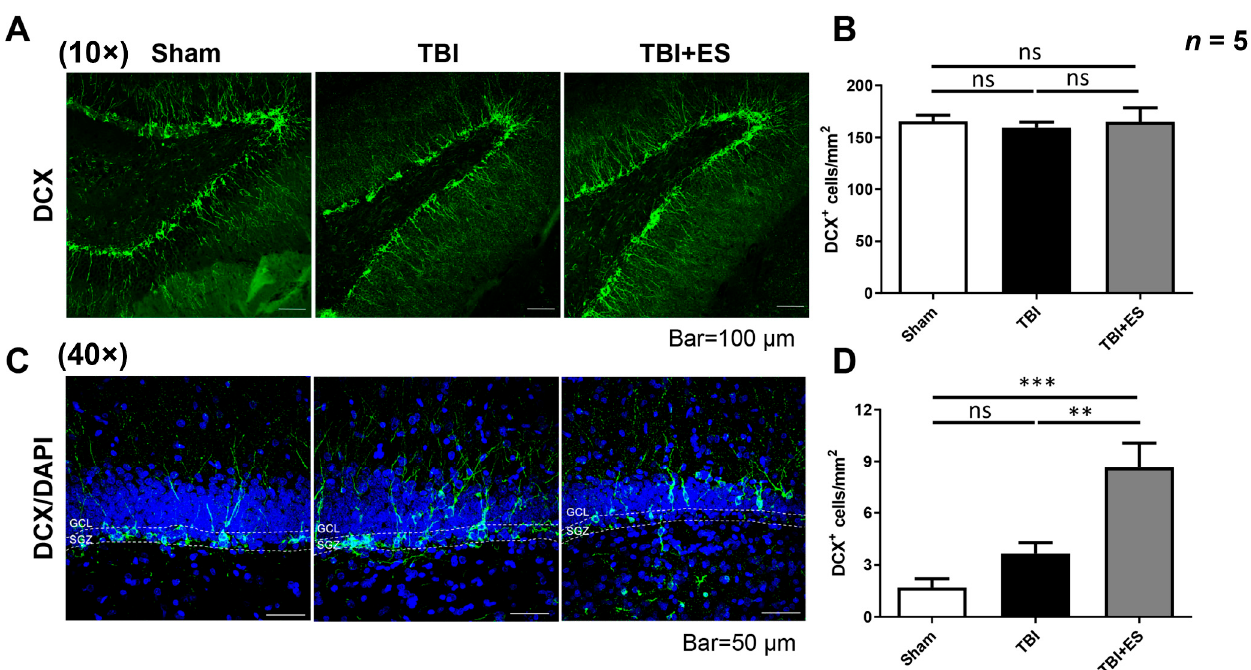
Figure 7. CES stimulates migration from the subgranular zone (SGZ) to the granular cell layer (GCL). ( A ) Representative pictures of the DCX immunofluorescence stain (green) of the dentate gyrus. ( B ) The quantification of DCX + cells in the dentate gyrus showed no significant difference between groups. ( C ) Highly magnified fluorescence pictures of DCX (green) and DAPI (blue) in the junctional zone between SGZ and GCL. ( D ) Quantitative analysis showed no significant difference in the number of DCX + cells in the junctional zone between the sham and TBI groups. In the TBI + ES group, there was a significant increase in DCX + cells in the junctional zone between SGZ and GCL, indicating that CES stimulates the migration of immature neurons from SGZ to GCL. Values are expressed as the mean ± SEM. ns, no significance; *** p < 0.001; ** p <